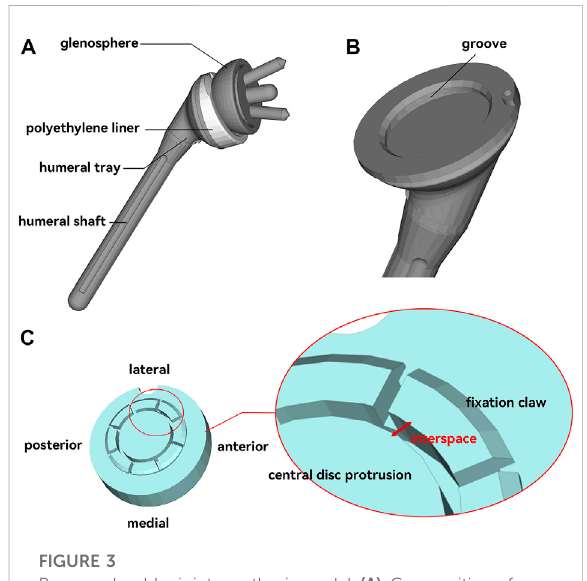
FIGURE 3 Reverse shoulder joint prosthesis model. (A) , Composition of thereverse shoulder jointprosthesis. (B) ,Metal humeraltray with a groove that can catch the polyethylene liner. (C) , Polyethylene liner with eight symmetrical “ claw ” structures for fi xation to the tray. The interspace between the claws and the intermediate disc-like protrusion was used as an indicator for this